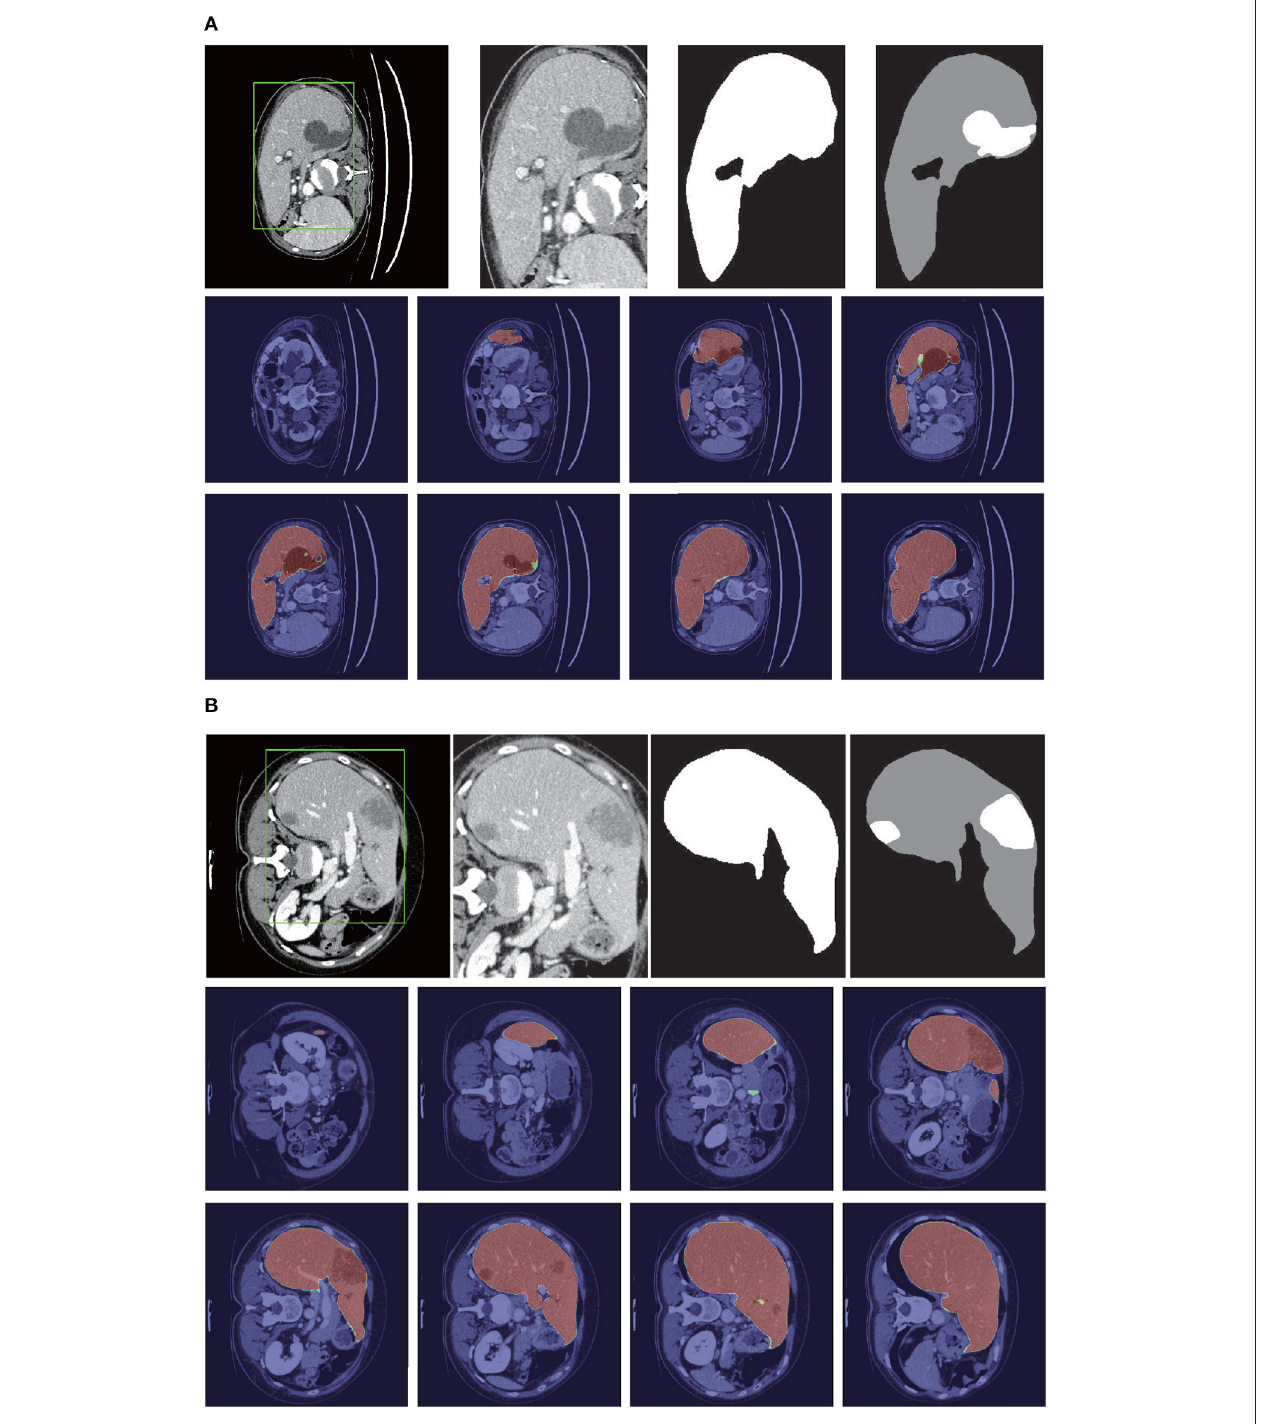
FIGURE 8 | Liver segmentation results based on RA-UNet-II. (A) From the LiTS validation dataset and (B) is from the 3DIRCADb dataset. From left to right, the first row of each subplot shows the liver in the green boundary box, magnified liver region, the liver segmentation results, and the corresponding ground truth. The second and the third rows show the probability heat map of liver segmentation results. The darker the color, the higher the probability of the liver region. Note that the ground truth contains liver in gray and tumor in white.